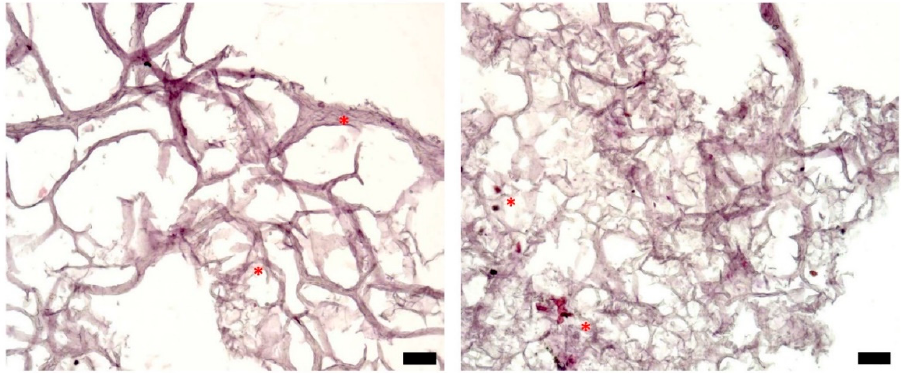
Figure 4. Histological analysis of representative sections of a triple-layered tissue construct (HE staining), day 0; optical microscopy, ob. 10×, scale bars = 10 µm. Stars highlight cells located in the bulk of the hydrogel.